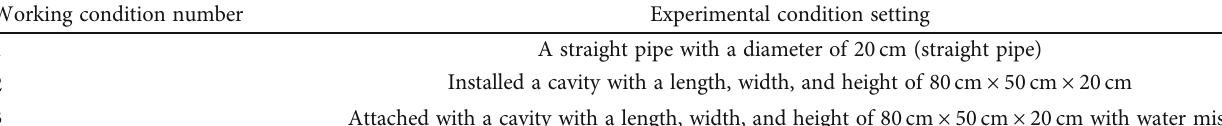
Figure 3: The schematic diagram of gas explosion experiment system. Table 1: The working conditions in the experiments.